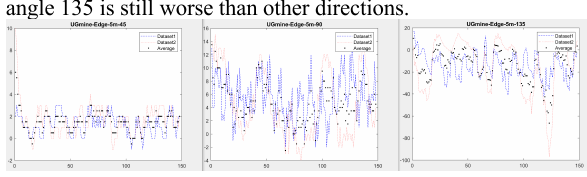
Figure 9 . Results of the tests at the edge of tunnel in underground mines.